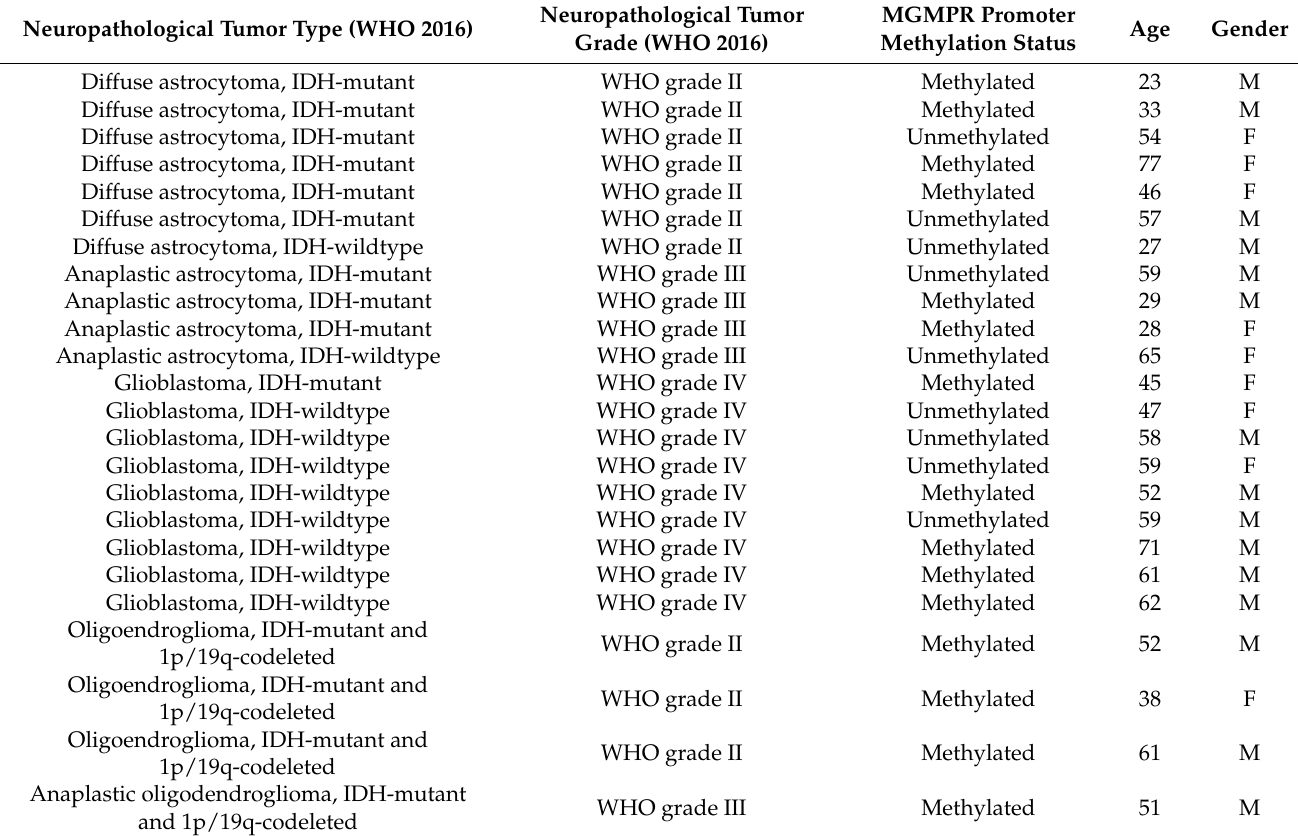
Table 1. Patient